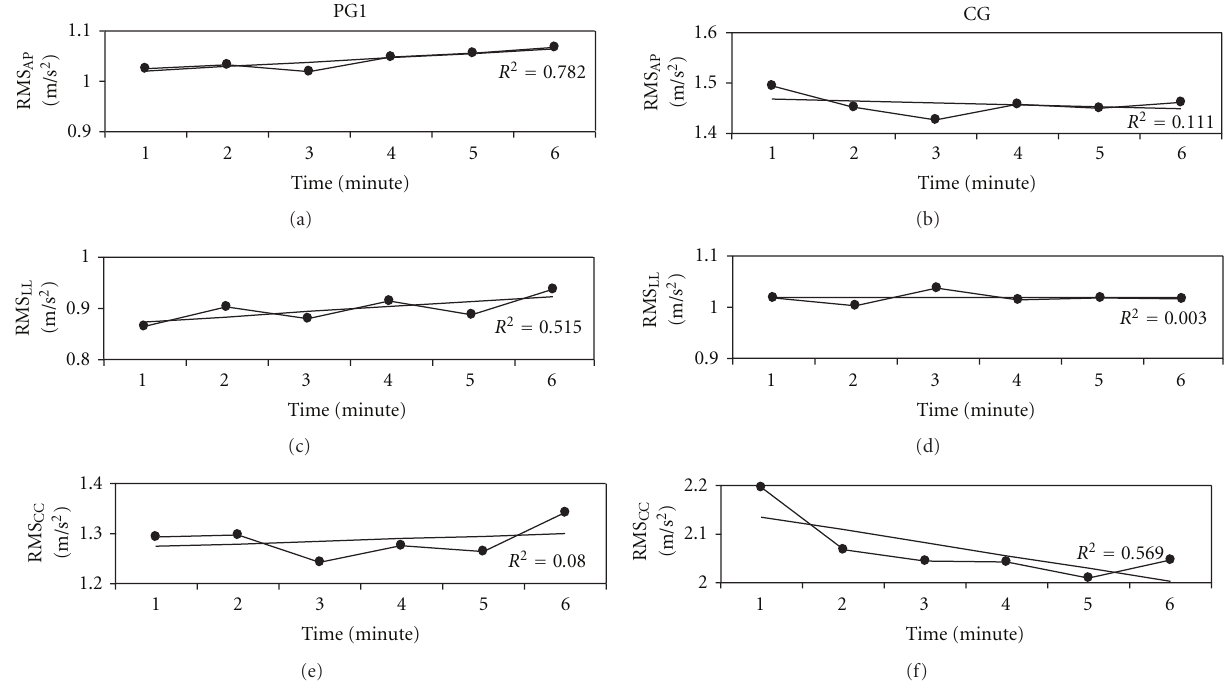
Figure 2: Acceleration RMS for PG1 ((a), (c), and (e)) and CG ((b), (d), and (f)) along anteroposterior ((a) and (b)), laterolateral ((c) and (d)) and craniocaudal ((e) and(f)) directions. Regression lines and relevant coe ffi cient of determination R 2 are also